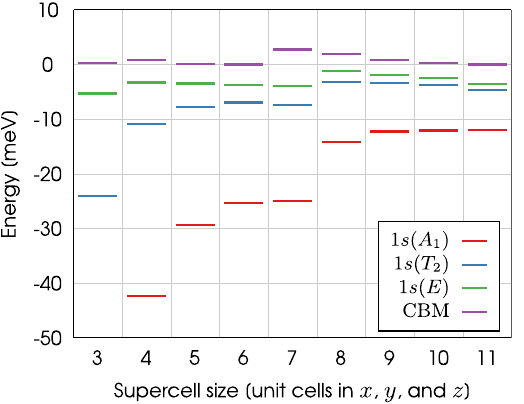
, s T 1 ( ) , and s E 1 ( ) states for supercells that range in size from 216 to 1 2